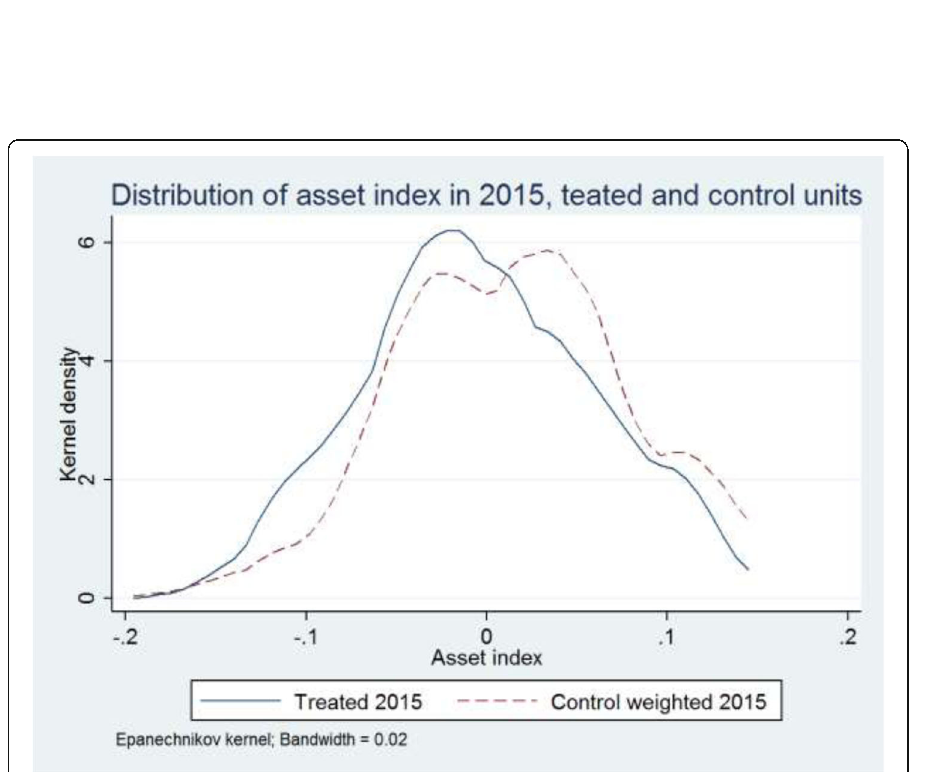
Fig. 3 Housing quality index of treated and control households in